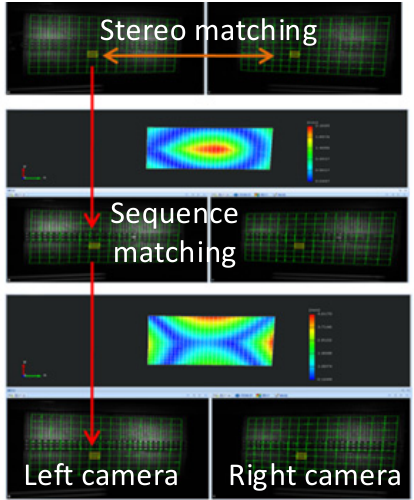
Figure 4. Speckle image matching.